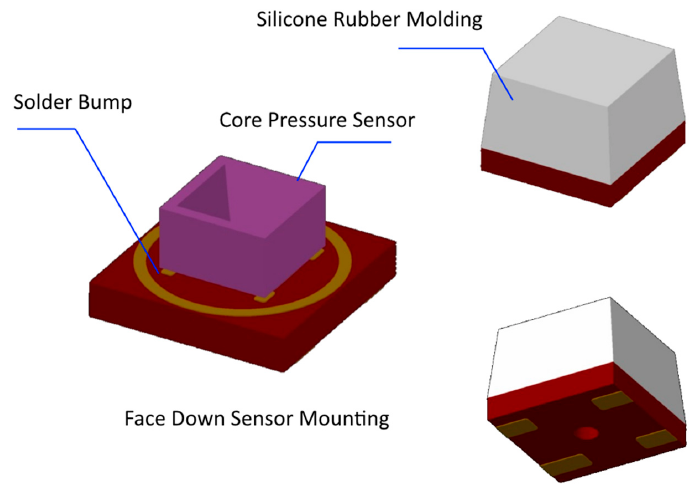
Figure 1. Independent pressure sensor unit (IPU) size: 2.5 mm × 2.5 mm × 2.7 mm.